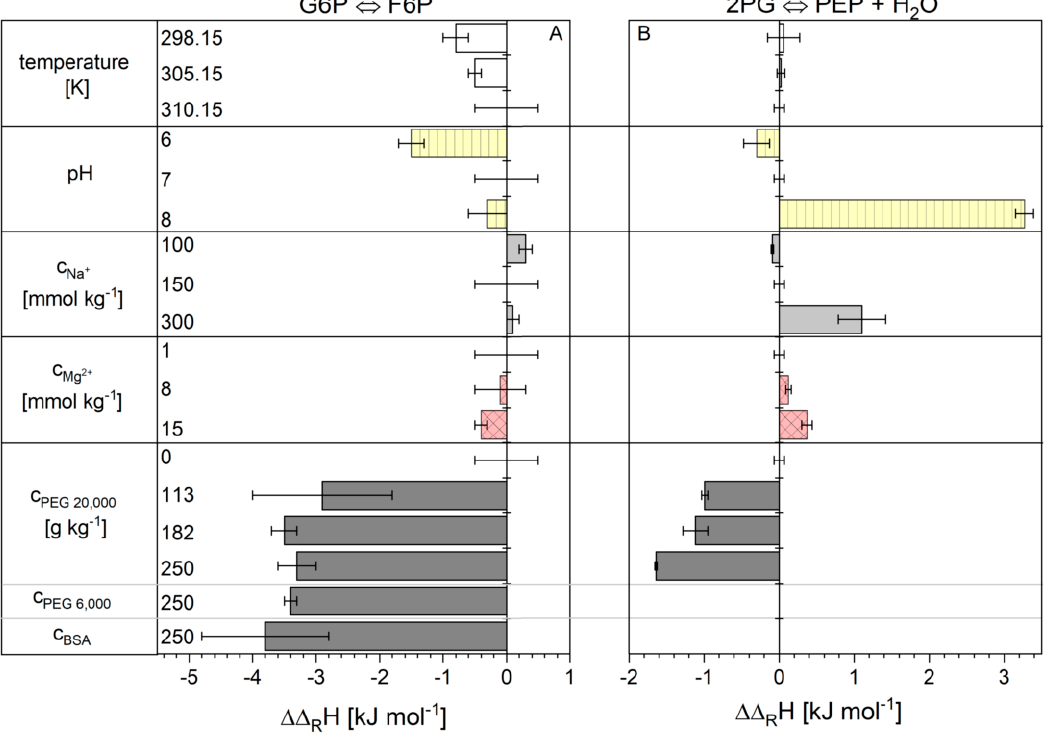
Figure 1. Di ff erence ( ∆∆ R H) between the reaction enthalpy changes under cytosolic conditions and basic conditions reaction 2 ( A ) and 9 ( B ). The reaction enthalpy change under basic conditions 11.1 ± 0.5 kJ mol − 1 for reaction 2 and 2.4 ± 0.1 kJ mol − 1 for reaction 9. The error bars result from the standard deviation of the triple determination of each measurement condition.